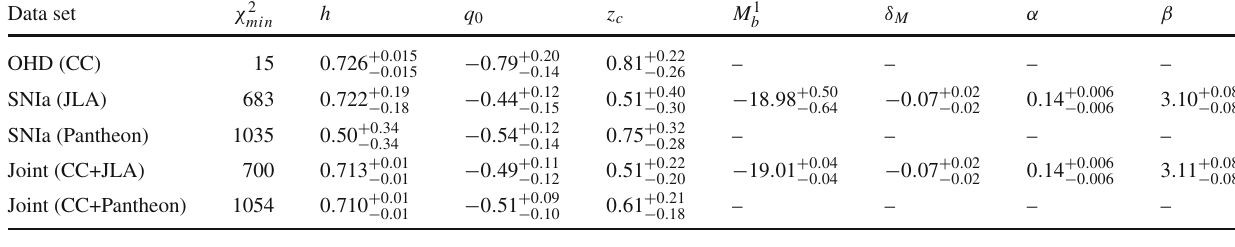
Fig. 2 1D marginalized posterior distributions and the 2D 68%, 95%, and 99 . 7% confidence levels for the h , q 0 and z c parameters for the joint analysis of SNIa+CC. The circle and the star represent the parameter mean values for the CC+JLA and the CC+Pantheon samples,